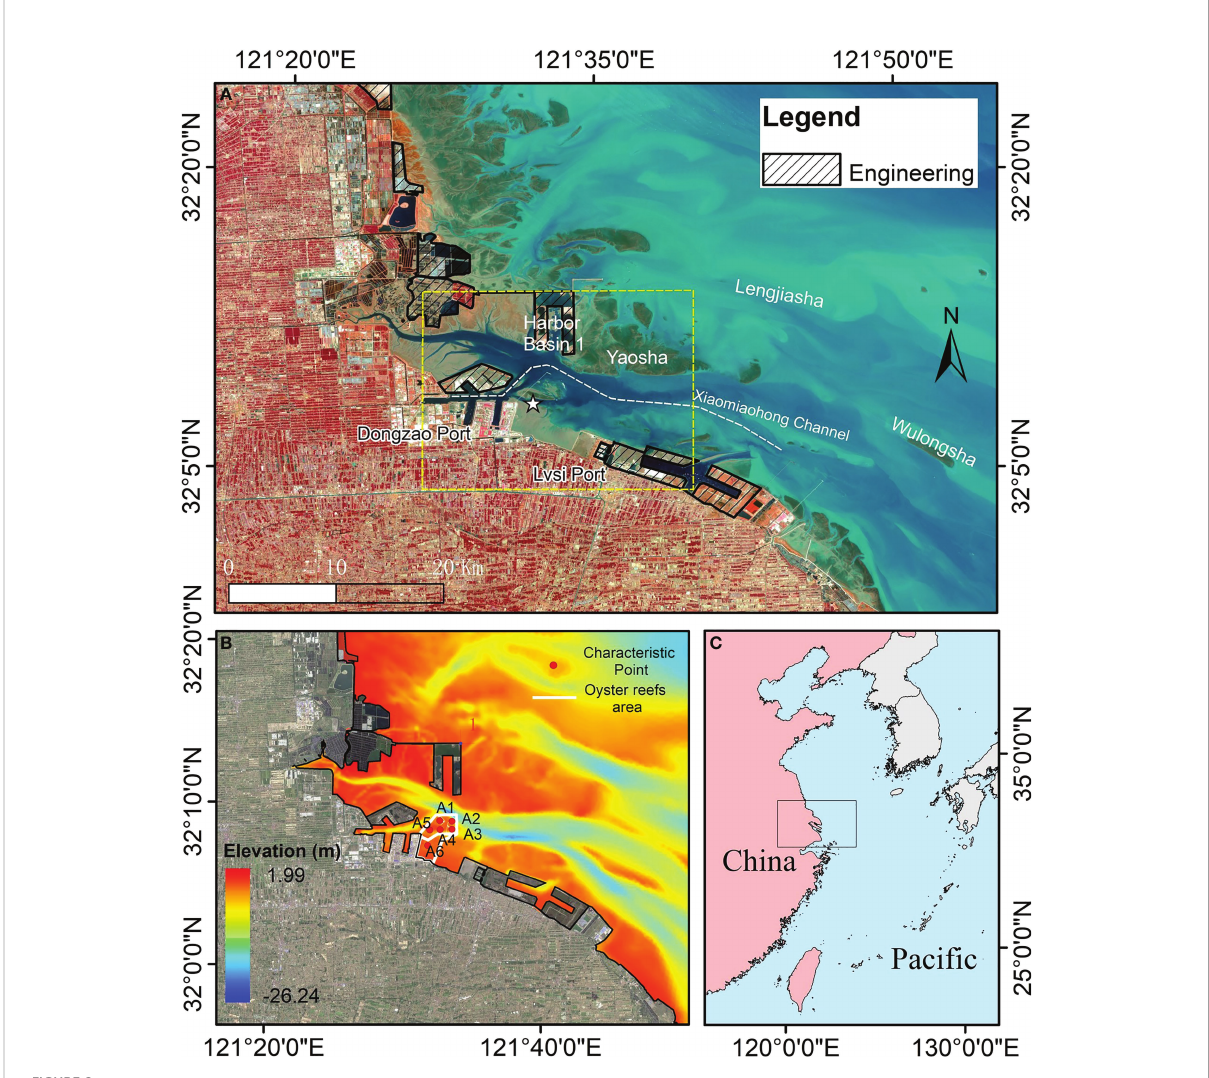
FIGURE 2 Location map of Liyashan Oyster Reefs. (A) Remote sensing image of the engineering area and oyster reefs (represented by a pentagram). (B) Selection of characteristic points in the oyster reef waters (A1 to A6). The elevation selection is National Vertical Datum 1985. (C) General location map of oyster reef